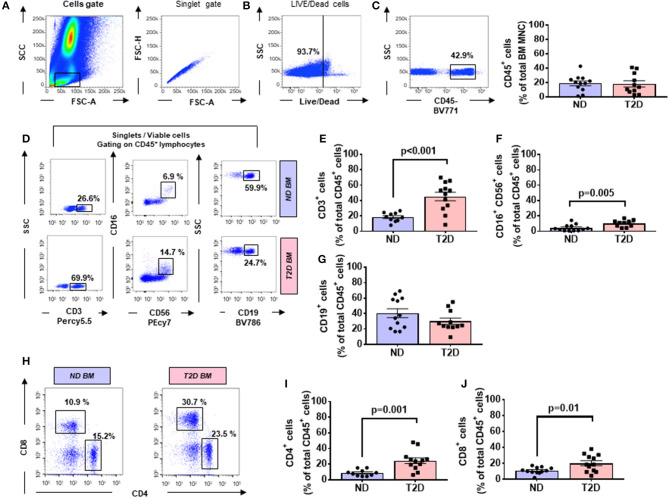
Flow cytometry analysis of immune cells in human bone marrow shows type 2 diabetes (T2D) is associated with an increased abundance of CD4+ and CD8+ cells. Scooped bone marrow (BM) from femoral head leftovers of orthopedic surgery was obtained from patients previously diagnosed to have T2D and controls without T2D (ND). (A) Lymphocytes were gated based on SSC-A vs. FSC-A, and singlets were selected from the FSC-A vs. FSC-H dot plot. (B) Subsequently, dead cells were excluded with Zombie NIR™ Fixable Viability Kit. (C–G) CD45+ cells to identify population subsets according to the staining for CD3 (T lymphocytes), CD19 (B lymphocytes), and CD16/CD56 (NK cells). (H–J) Gating for CD4 and CD8 (H) Bar graphs showing the frequency of CD4+ cells (I) CD8+ cells (J). Reported frequencies are illustrative of a representative case for each group. Values are mean ± SEM, with each point representing an individual case.